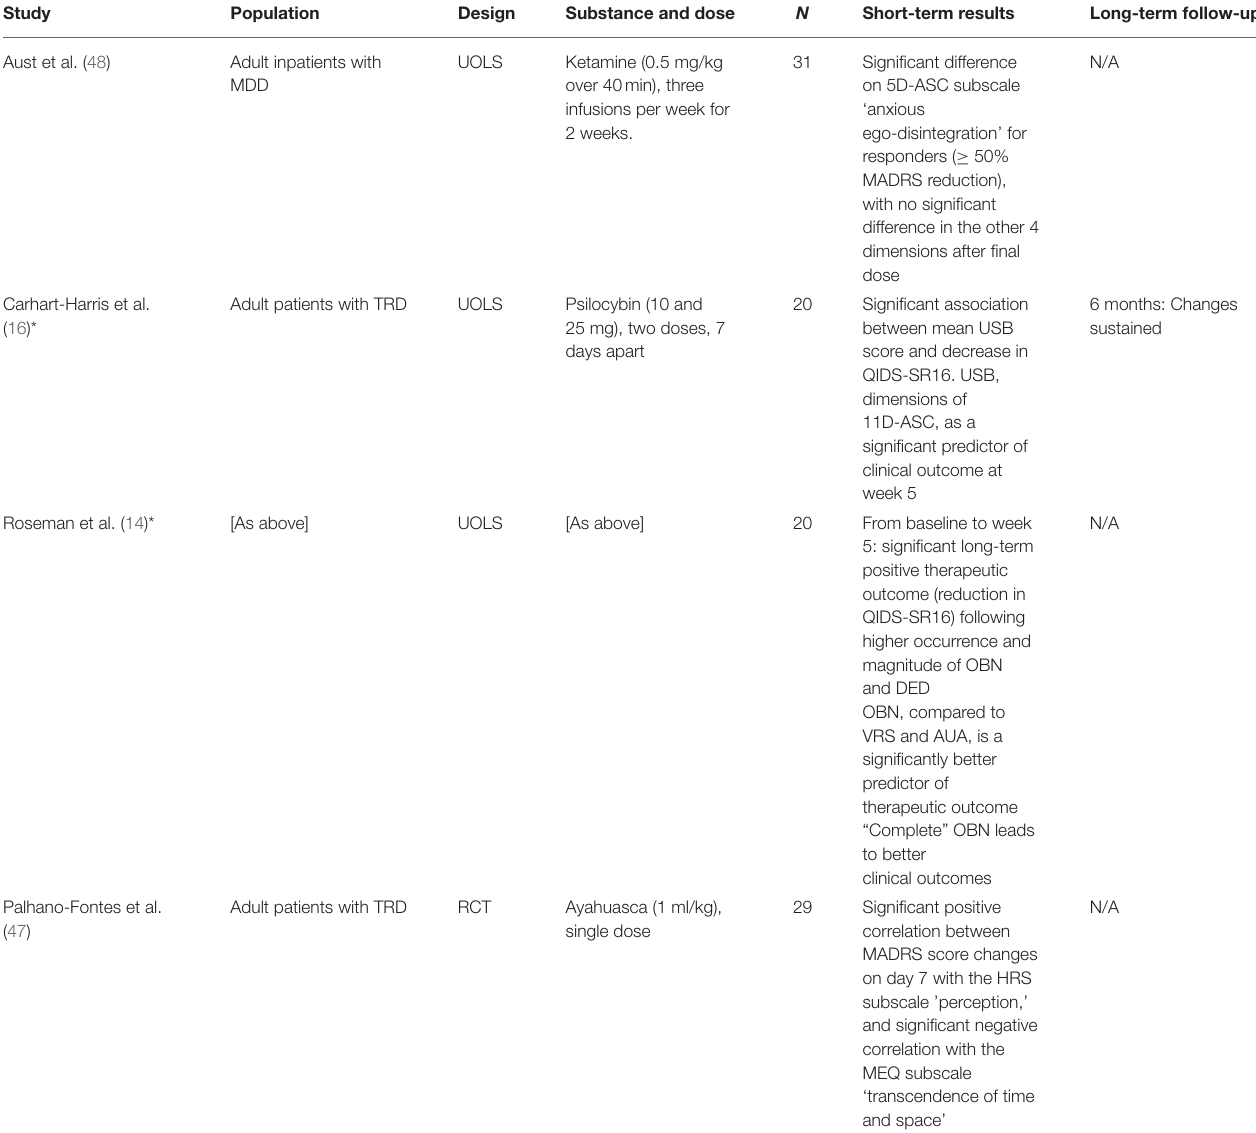
TABLE 4 | Depressive disorder